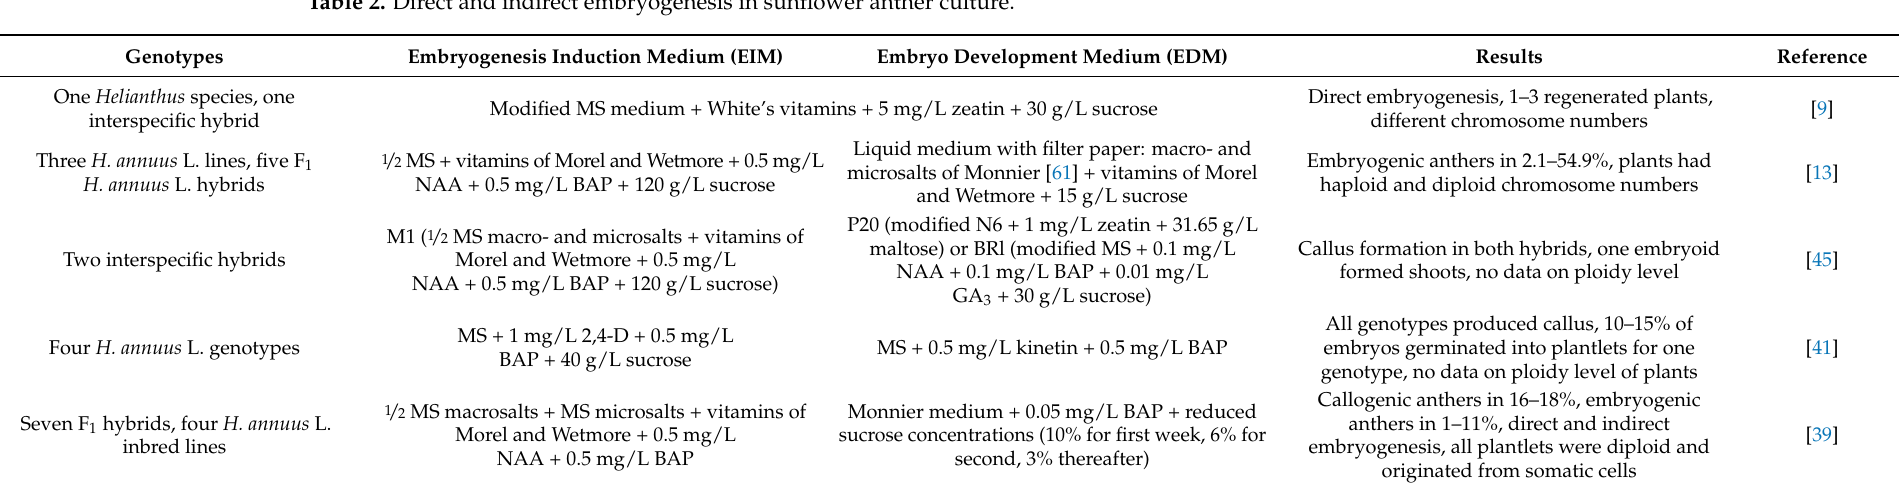
Table 2. Direct and indirect embryogenesis in sunflower anther